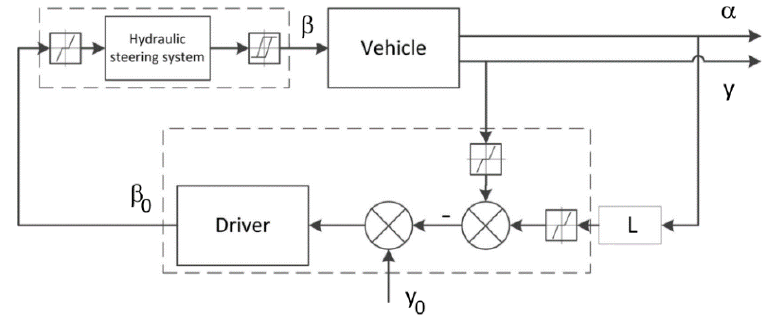
Figure 9. Steering control loop with non-linearity in driver behavior.